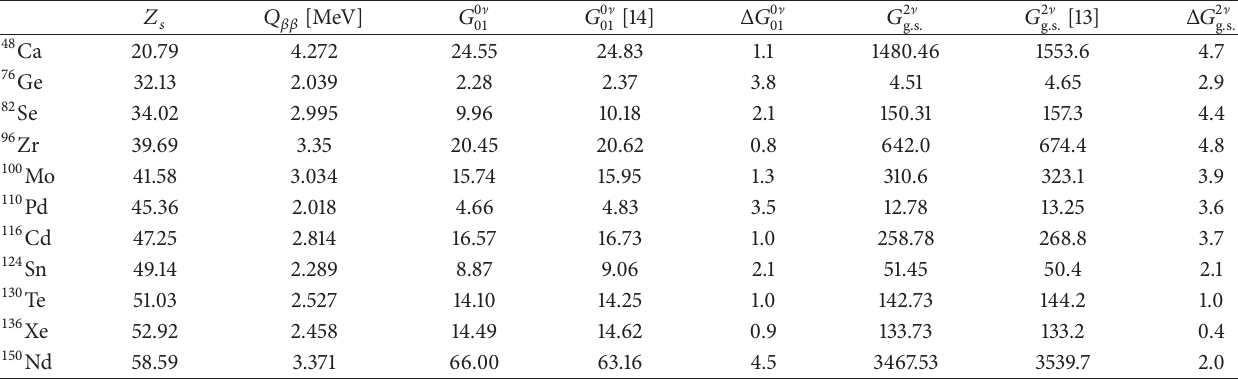
expressed in yr −1 × 10 22 . The last two columns present PSF 1